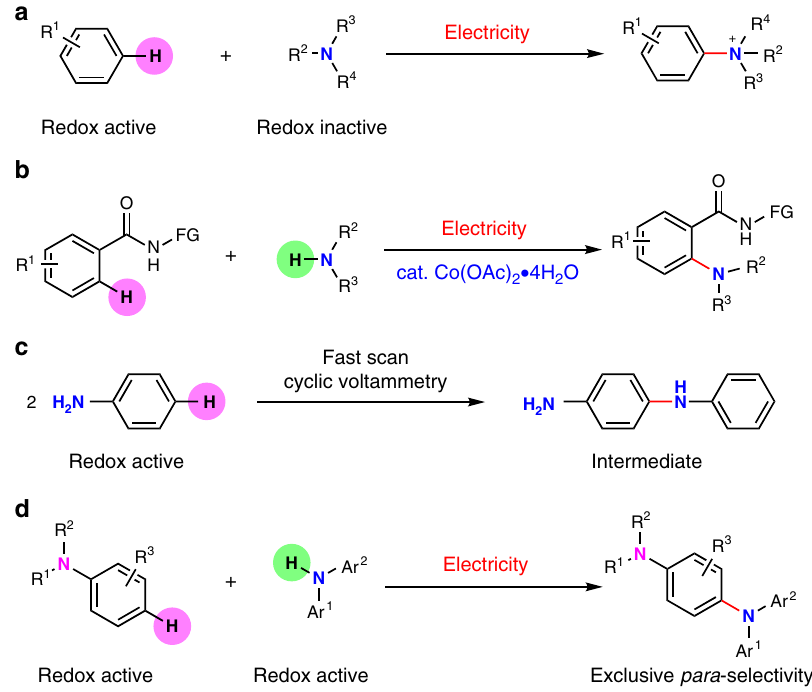
Fig. 1 Electrooxidative intermolecular aryl C – H amination. a Electrooxidative aryl C – H amination of arenes with redox inactive pyridine and imidazoles. b Cobalt-catalyzed electrooxidative ortho -selective aryl C – H amination of arenes with secondary amines. c Electrooxidative homo-coupling of aniline in fast scan cyclic voltammetry. d Catalyst-free electrooxidative para -selective aryl C – H amination of anilines with diarylamine